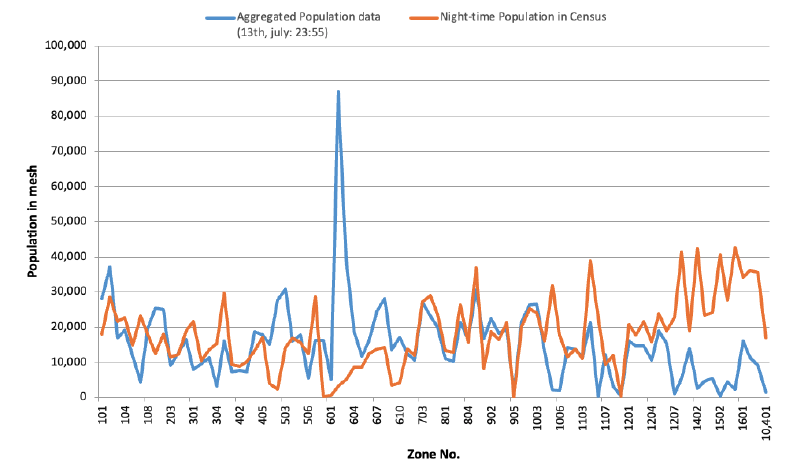
Figure 1. Comparison between aggregated population and nighttime population.